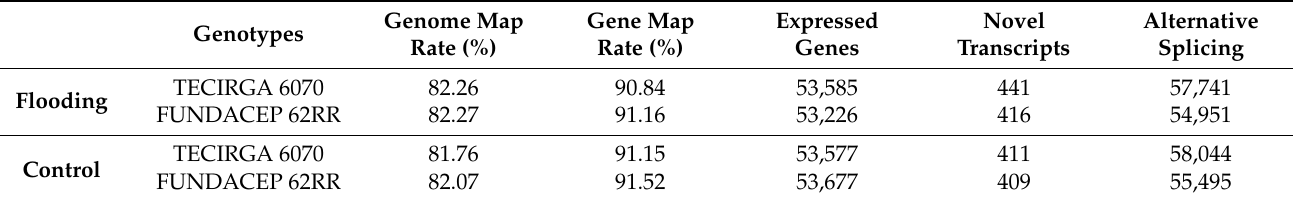
Table 1. Output statistics of transcriptome sequencing.